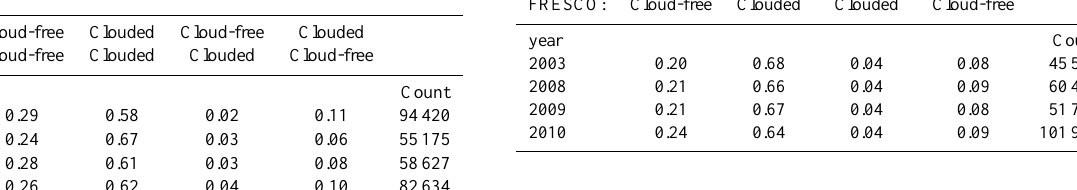
Table 4. Comparison of scene identifications between SPICI and FRESCO over time. A total of 260 × 10 3 SPICI observations were compared to co-located averaged FRESCO observations. A scene is considered clouded by FRESCO when the average FRESCO cloud- fraction over the scenes is more than 10%. The table shows the fraction of the total number of SPICI observations which fall under the catagory indicated in the top of the table. Total number count of SPICI obervations employed for the comparison for each year in the right